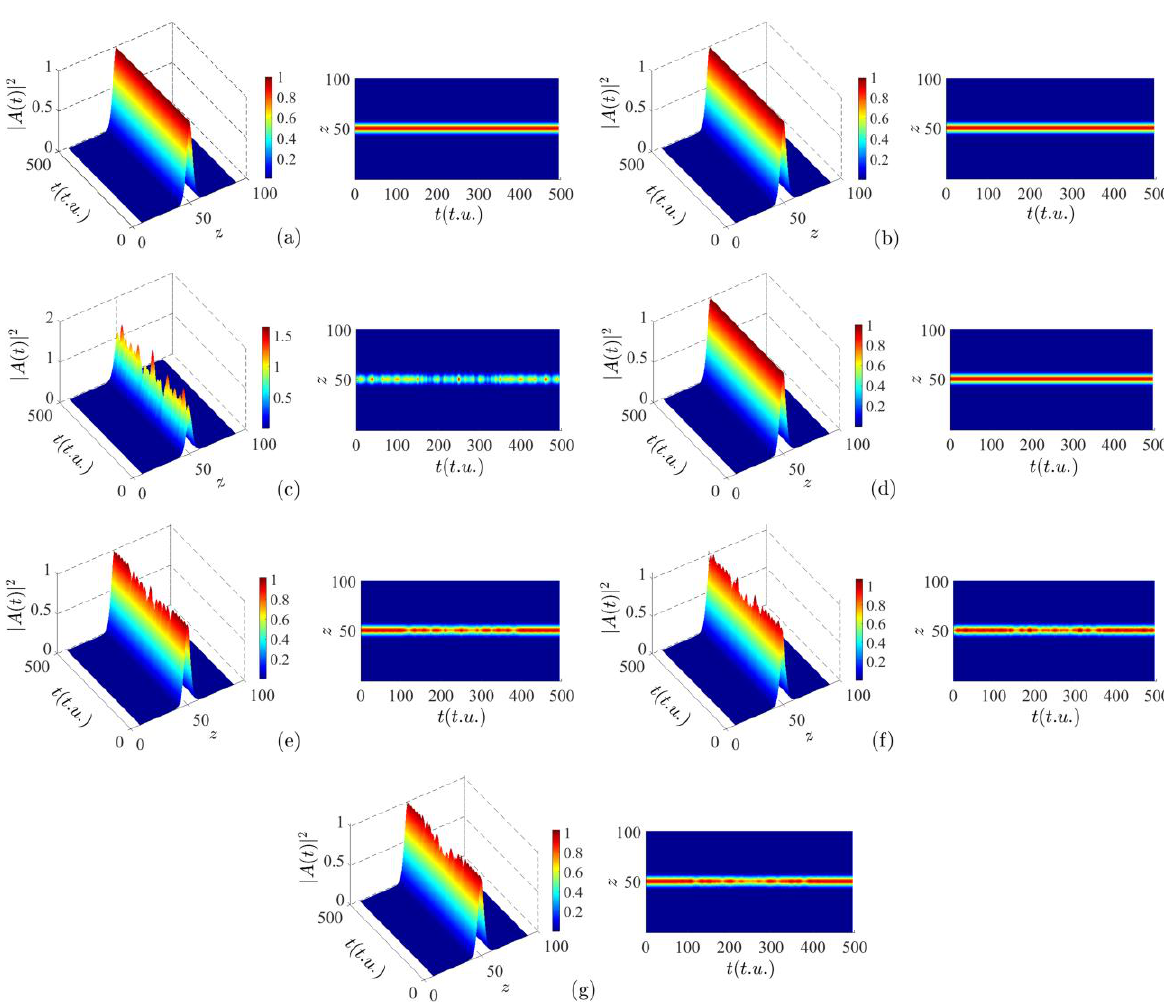
Figure 5. The temporal behavior of the soliton-like on DNA system in the NH Thermostat for temperature values: (a) T = 300 K, (b) T = 325 K, (c) T = 350 K, (d) T = 385 K, (e) T = 400 K, (f) T = 425 K, and (g) T = 450 K [left is surface; right is